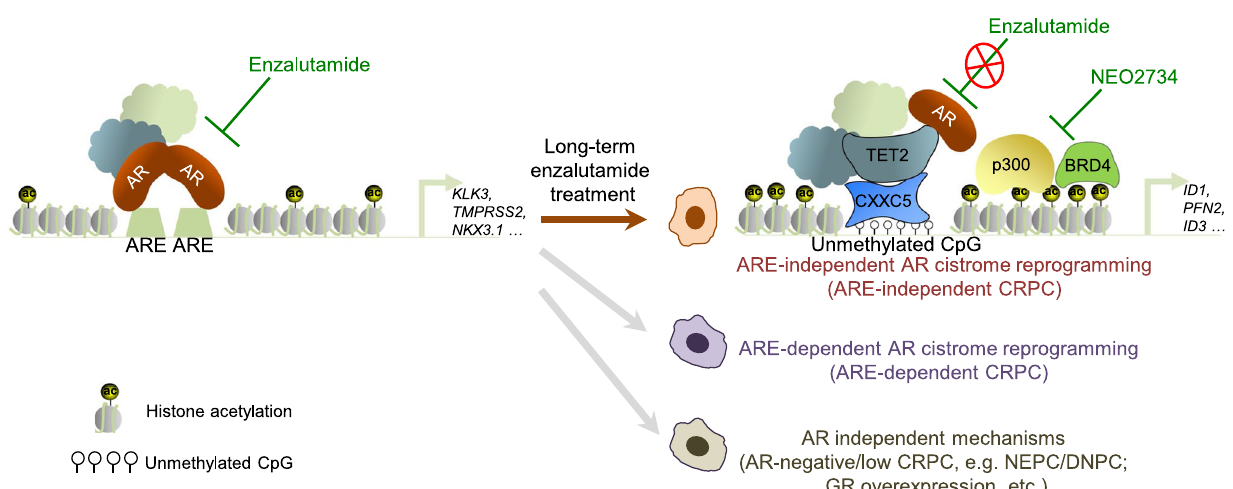
Fig. 7 A hypothetical model deciphering the mechanisms of EZN-sensitive and ENZ-resistant CRPC. AR androgen receptor, ARE androgen response element, ac acetylation, CRPC castration-resistant prostate cancer, NEPC neuroendocrine prostate cancer, DNPC double-negative (AR-null/ neuroendocrine-null) prostate cancers, GR glucocorticoid receptor, CXXC5 CXXC Finger Protein 5, TET2 Tet Methylcytosine Dioxygenase 2, BRD4 Bromodomain-containing protein 4, p300 Histone acetyltransferase